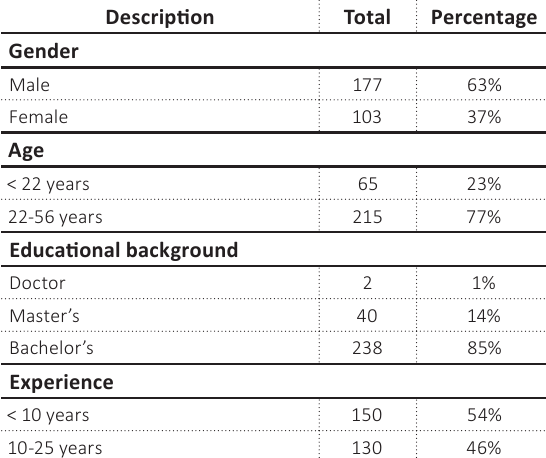
Table 2. D escription of respondents